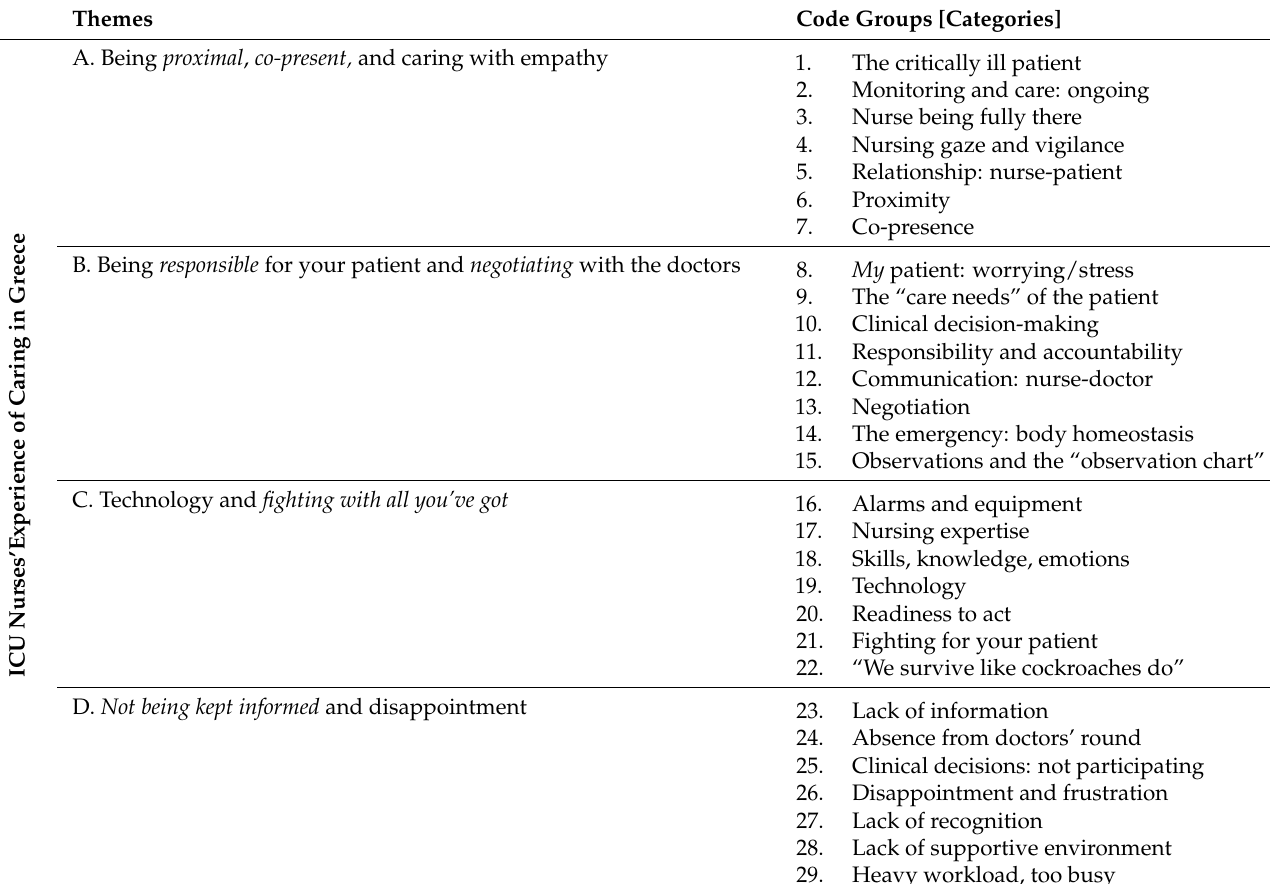
Table 4. Overview of themes and code